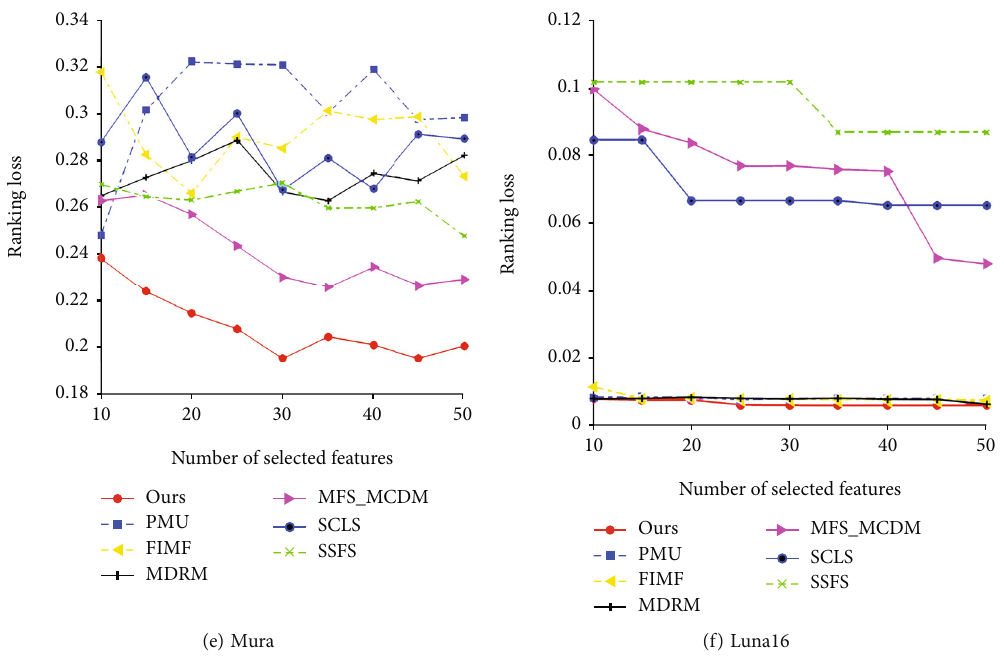
Figure 3: Ranking loss: the quality of each algorithm varies with the selected feature